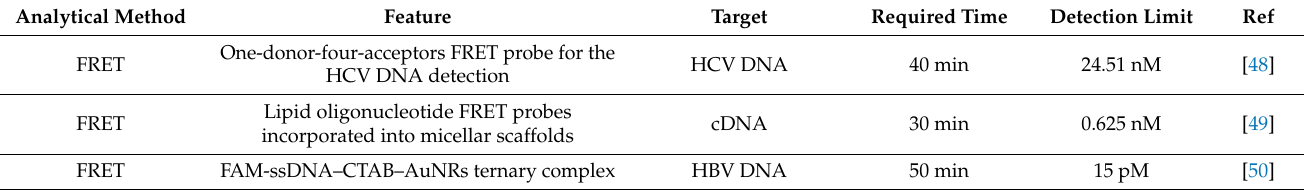
Table 1. Comparison of fluorescent-based plasmonic nanobiosensors for viral DNA detection. Analytical